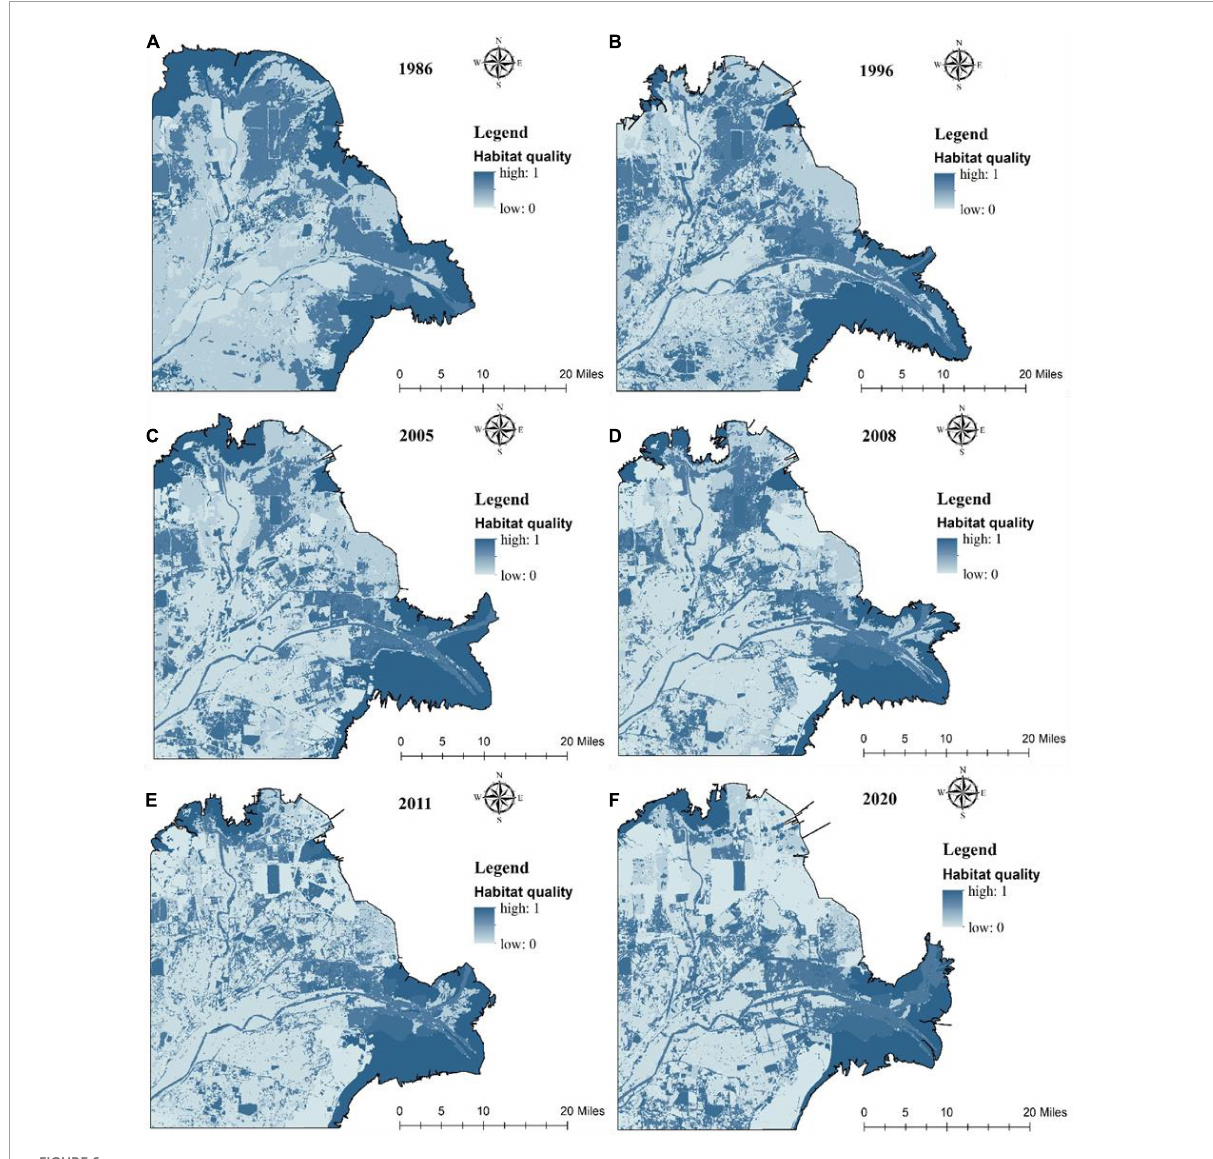
FIGURE6 Habitat quality spatial distribution in the Yellow River Delta Wetland, 1986 (A) , 1996 (B) , 2005 (C) , 2008 (D) , 2011 (E) , and 2020 (F) .